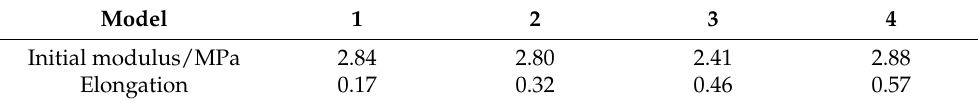
Figure 6. Stress-strain curves of propellants with different particle sizes. Table 5. Mechanical property of propellants at different gradations.